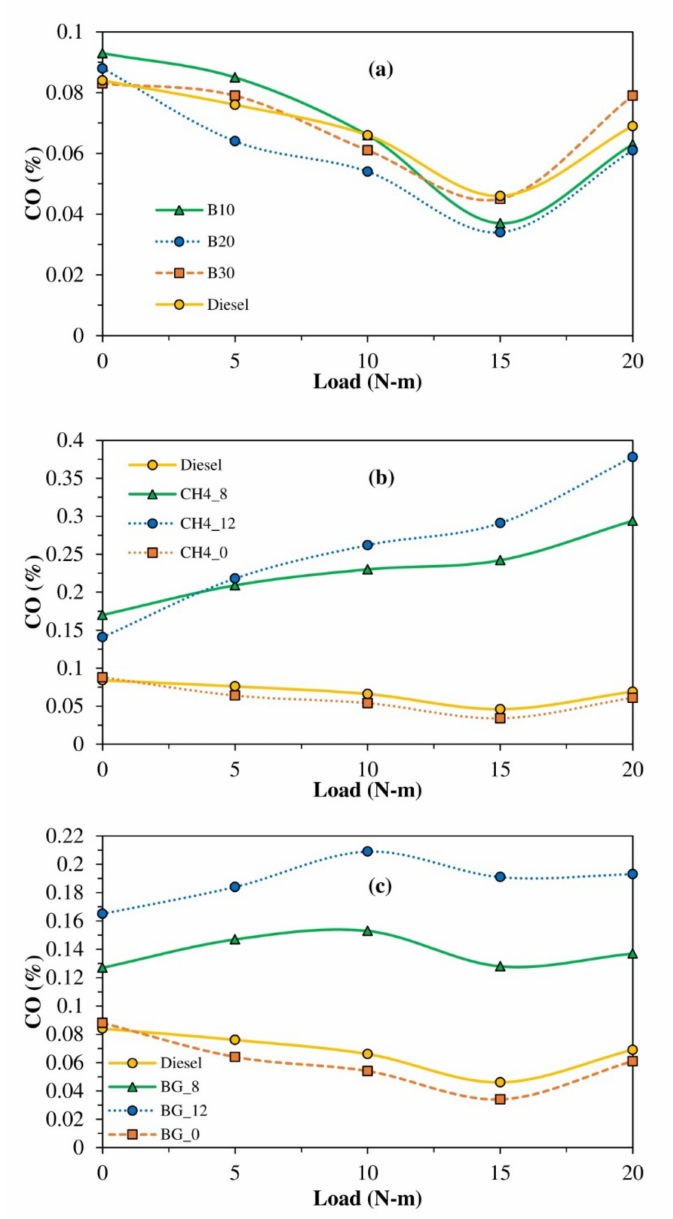
Figure 6. Variation of CO emissions with load at various ( a ) Mahua biodiesel blend, ( b ) methane flow rate and ( c ) biogas flow